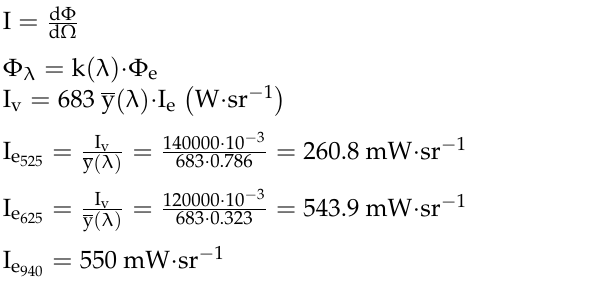
Figure 9. Switched-on illumination device diffusion filter differences: left —no filter applied, middle —Lee 250 Half White Diffusion Filter, right —Lee 216 Full White Diffusion Filter.